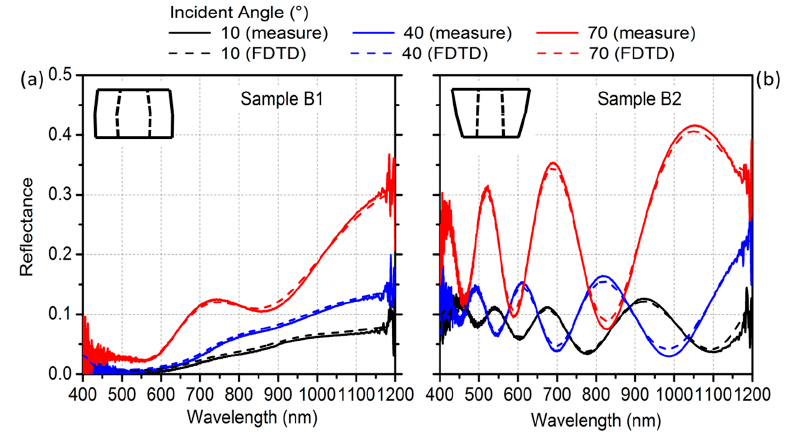
Figure 4. Comparison between experimental reflectance and finite-difference time-domain (FDTD) simulations. ( a ) Measured (solid line) and simulated (dashed line) specular reflectance for the nontapered C–S, sample B1; ( b ) measured (solid line) and simulated (dashed line) specular reflectance for the tapered C–S, sample B2. Materials 2019 , 12 , x FOR PEER REVIEW